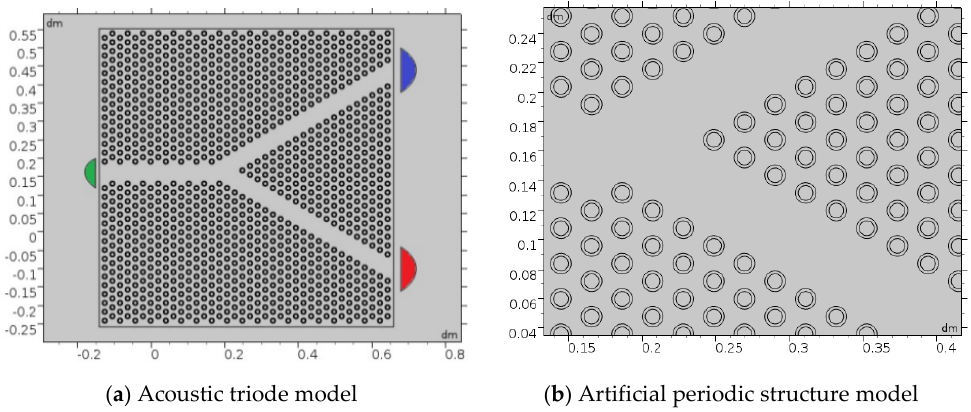
Figure 1. Sonic triode based on artificial periodic structure: ( a ) Acoustic triode model; ( b ) artificial periodic structure model.